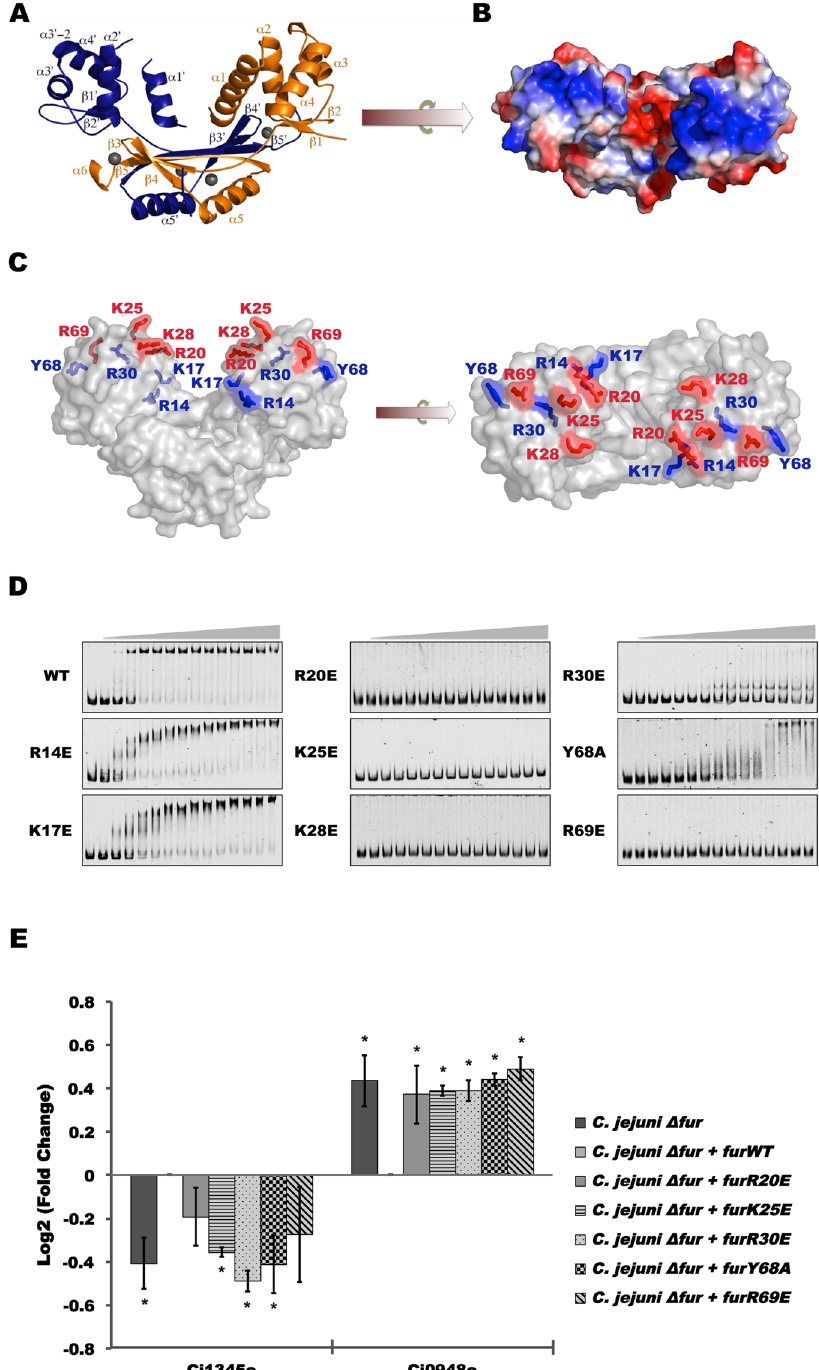
Figure 1. Apo-CjFurZn 2 structure and regulation. ( A ) CjFur is composed of a N-terminal DNA binding domain and a C-terminal dimerization domain. Protomer A and protomer B are rendered in orange and blue, respectively, and the zinc atoms are represented by gray spheres. Secondary structures are labeled. ( B ) The electrostatic potential surface of apo-CjFur is represented. ( C ) Residues forming the positively charged surface were mutated to glutamic acid or alanine residues. Mutations impairing the DNA binding activity of apo-CjFur are rendered in red, and mutated residues that still bind to DNA are highlighted in blue. ( D ) EMSA of the cj1345c promoter region (2 nM) with increasing amounts (0–1000 nM) of CjFurWT, CjFurR14E, CjFurK17E, CjFurR20E, CjFurK25E, CjFurR30E, CjFurY68A and CjFurR69E. ( E ) RT-qPCR analysis of the expression of the Fur-regulated cj1345c and cj0948c genes in C. jejuni Δ fur , Δ fur + furWT , Δ fur + furR20E , Δ fur + furK25E , Δ fur + furR30E , Δ fur + furY68A and Δ fur + furR69E . All values are relative to C. jejuni Δ fur + furWT and normalized to slyD (endogenous control) and to fur